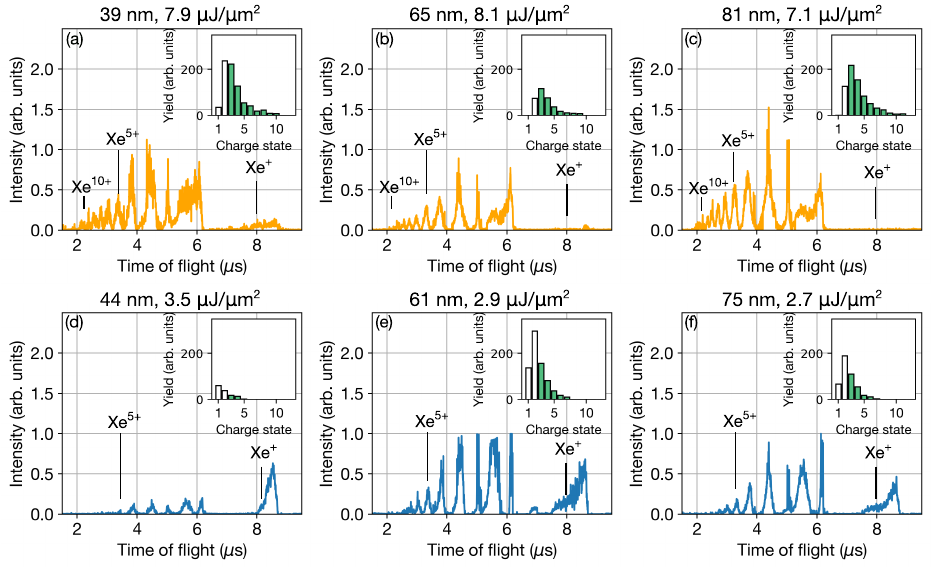
Figure 5. Ion TOF spectra of Xe clusters with sizes of approximately ( a , d ) 40 nm, ( b , e ) 60nm, and ( c , f ) 80 nm. TOF spectra observed for high FEL fluences ( ∼ 8 µ J µ m − 2 ) are shown in ( a – c ) , and those observed for low FEL fluences ( ∼ 3 µ J µ m − 2 ) are shown in ( d – f ). Ion charge states of each peak